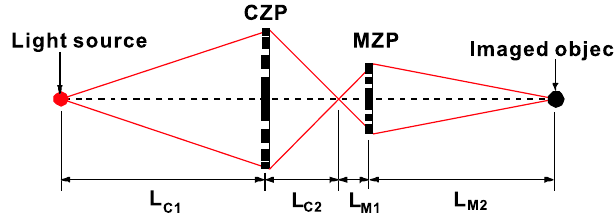
FIG. 1. (Color) X-ray imaging optics with two FZPs (CZP and